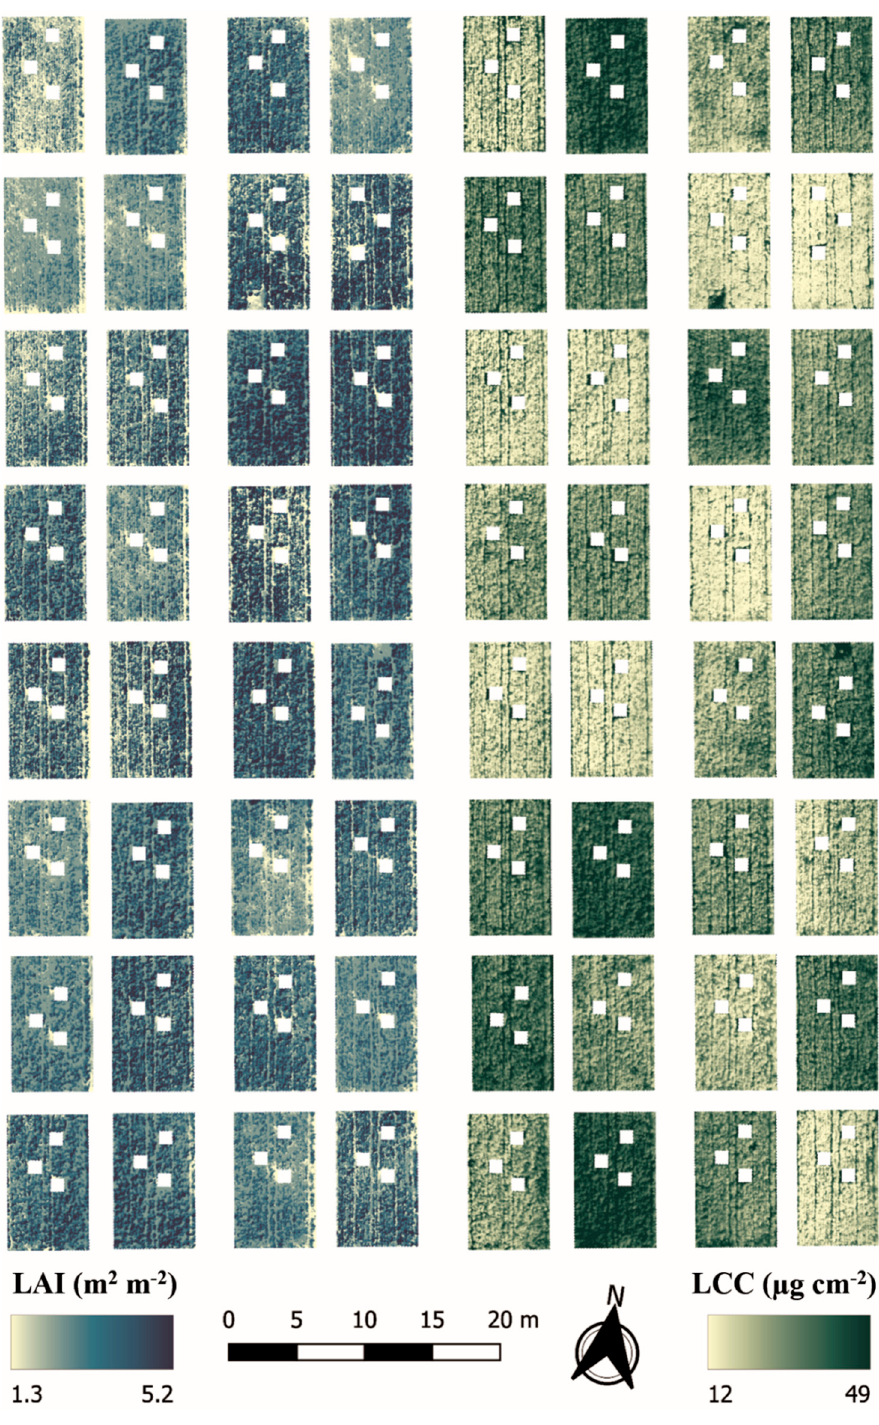
Figure 10. Maps of LAI and LCC estimated on 105 DAS during the growing season 2020 by UAV multispectral images using the best inversion of the PROSAIL model (RF for LAI and GPR for LCC). White squares inside the plots correspond to destructive samplings.